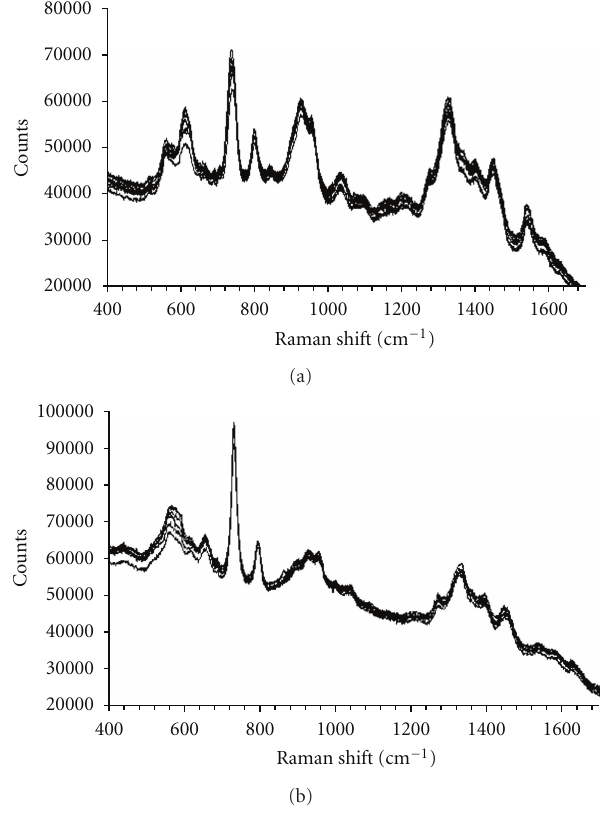
Figure 7: Reproducibility of SERS spectra of E. coli (a) and S.cohnii (b). SERS spectra acquired from di ff erent locations on AgNP microwell